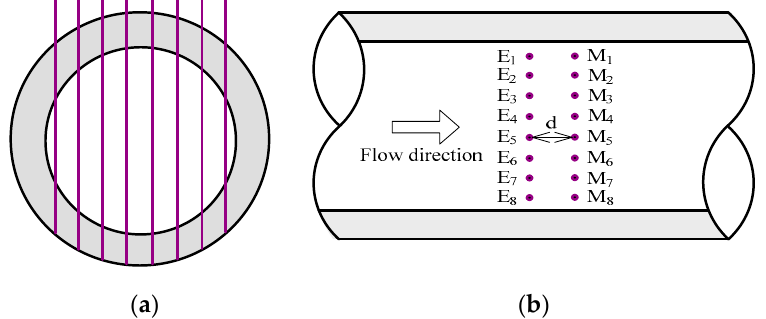
Figure 3. Sketch of the conductance parallel-wire array probe (CPAP) structures: ( a ) Front view for parallel-wire electrodes; ( b ) Top view.